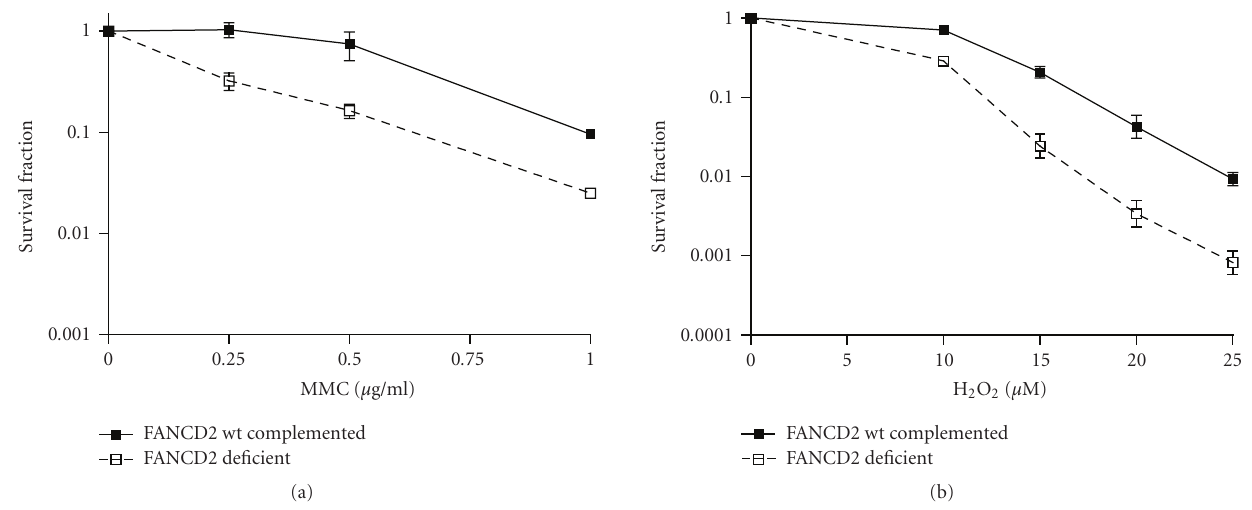
Figure 1: Hypersensitivity of FANCD2-deficient human fibroblasts to DNA damage. (a) Clonogenic survival of cells with or without wild- type FANCD2 (PD20-wtD2 or PD20, resp.) after treatment with varying concentrations of MMC for one hour. (b) Analogously, clonogenic survival after exposure to hydrogen peroxide (H 2 O 2 ) for two hours. Data represent logarithmic means +/ − standard error based on four independent repeats.